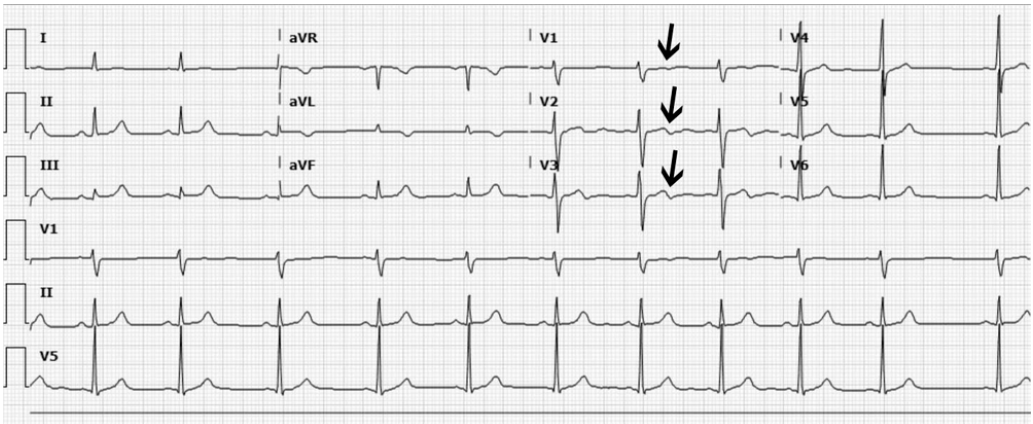
Figure 1: ECG showing subtle biphasic T waves in V1–V3.